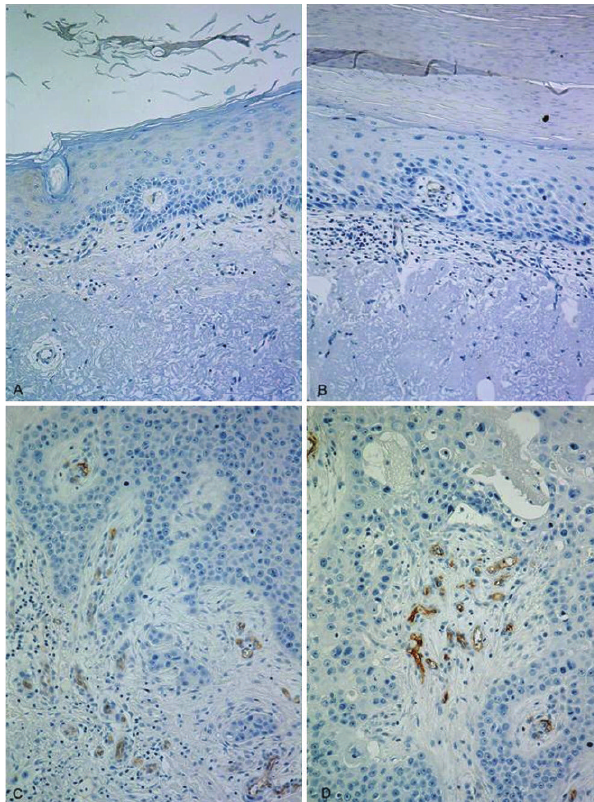
Figure 2 - Vascular hot spots in CD105-stained adjacent non- neoplastic skin ( A ), SK ( B ), siSCC ( C ), and iSCC ( D ).